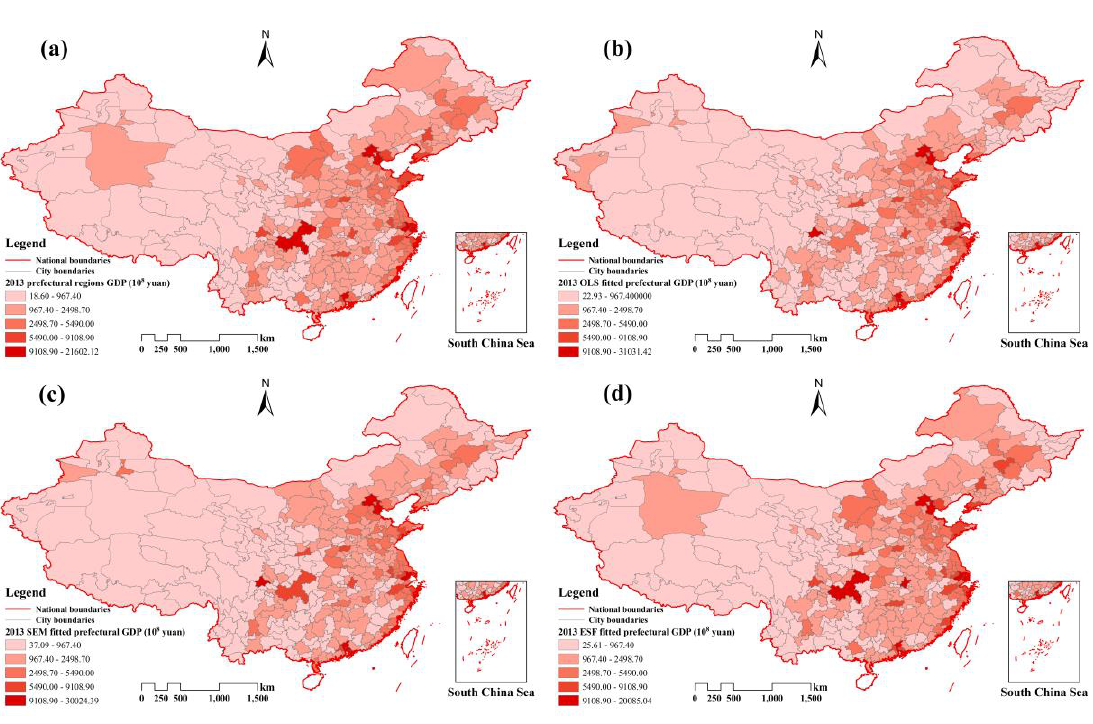
Figure 3. China prefecture GDP map in 2013: ( a ) original GDP distribution. ( b ) OLS fitted GDP distribution. ( c ) SEM fitted GDP distribution. ( d ) ESF regression fitted GDP distribution.